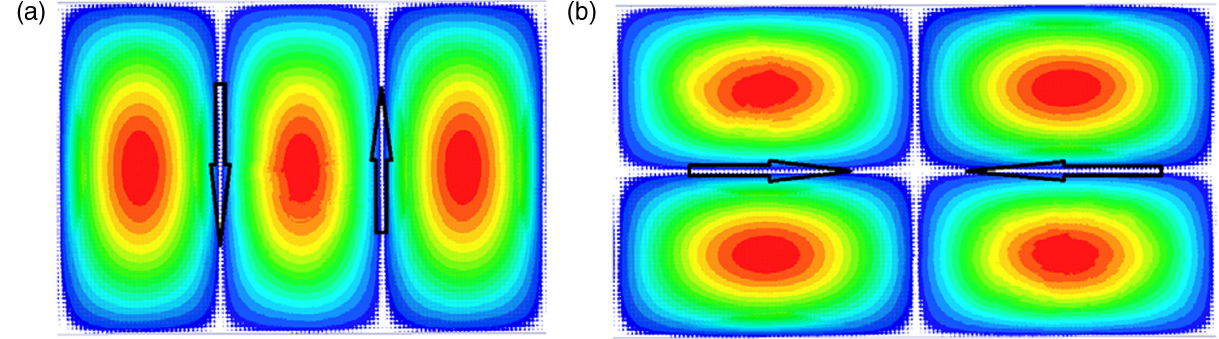
FIG. 3. Demonstration on vector electric field patterns of TE10 and TE20 in a rectangular waveguide. A: TE10 mode; B: TE20 mode. Electric fields are along the longitude direction. The black arrow is the electric field